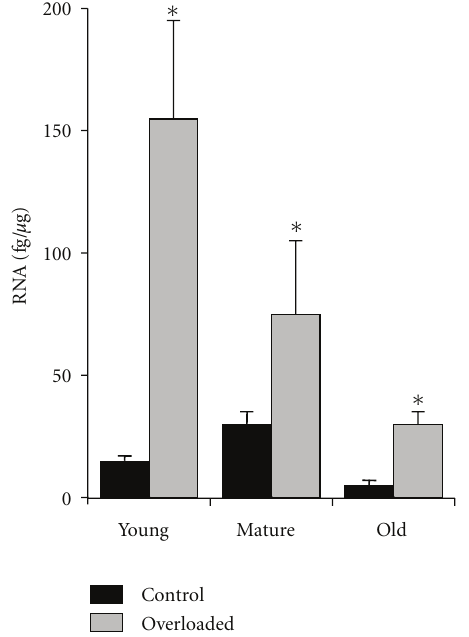
Figure 2: The ability to express MGF in response to mechanical strain with age. Animal experiments overloading the rat soleus and plantaris muscles by cutting the gastrocnemius muscle of rats from 3 age groups. In the young rat the overloaded muscles produced high levels of MGF but in the older rats the induced levels were much lower even though these rats were much heavier. The middle-age rats the MGF levels were intermediate between the young and the old in response to mechanical overload, according to Owino et al.